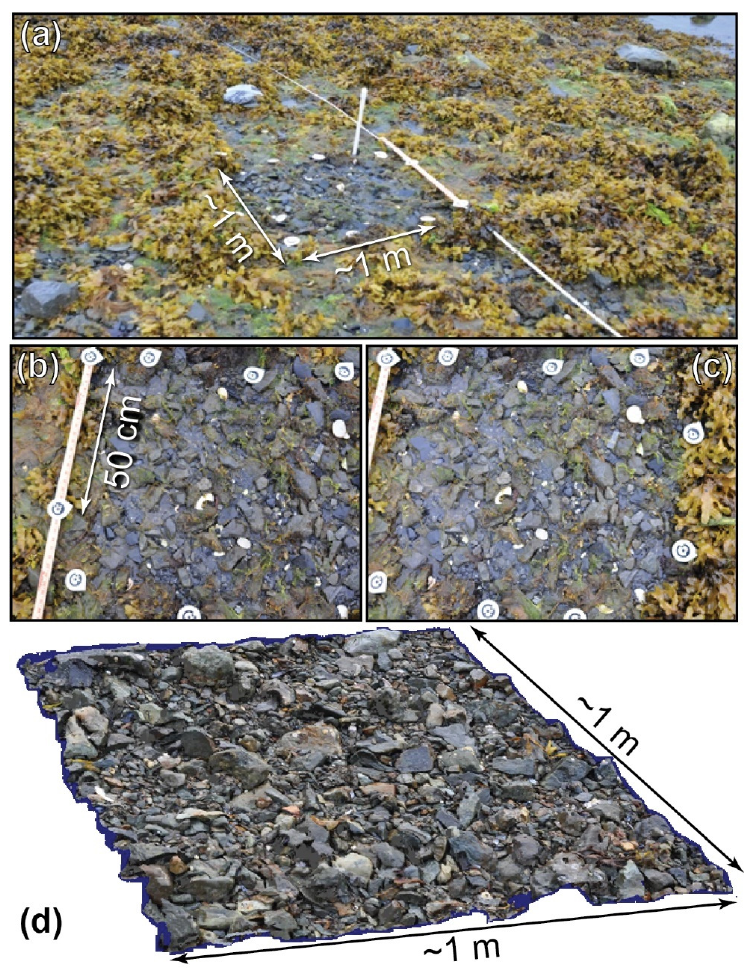
Figure 5. Field photographs of Plot #1 at study site FL3C. ( a ) Overview photo of study plot. Note tape measure marking topographic contour used in biological sampling of Lees et al. [34] ( b ) and ( c ) downward-looking stereophoto pair of photoplot. Scale is provided by the meter stick on which coded targets are positioned exactly 50 cm apart. ( d ) Three-dimensional dense grid exported for analysis as a digital topographic model.